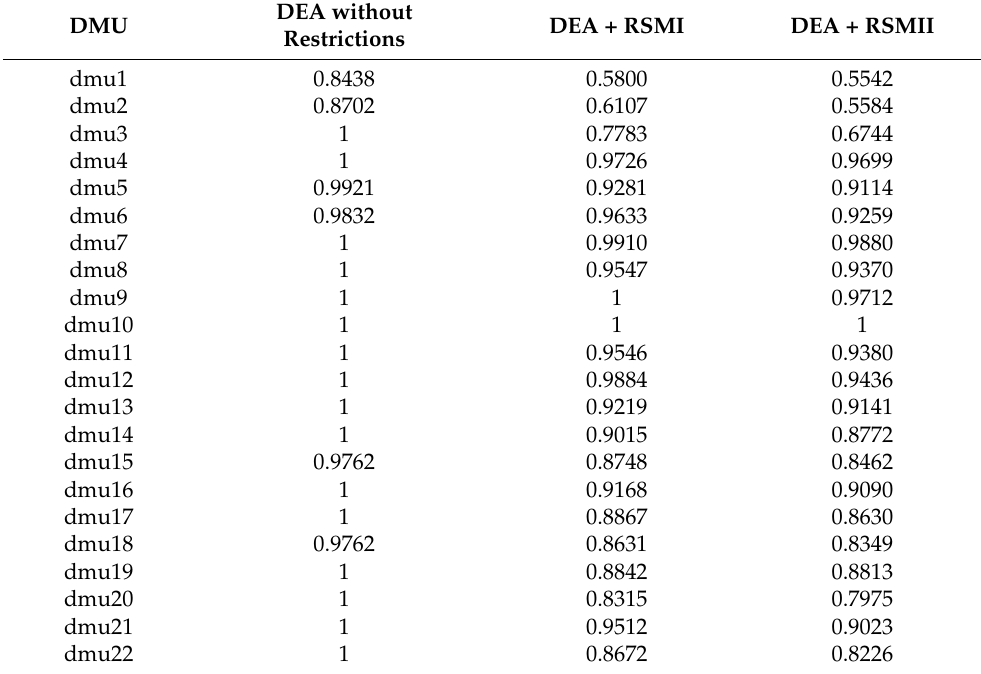
Table 11. Efficiency scores on DEA models with assurance regions from revised Simos’ method. DEA without DEA + DMU Restrictions